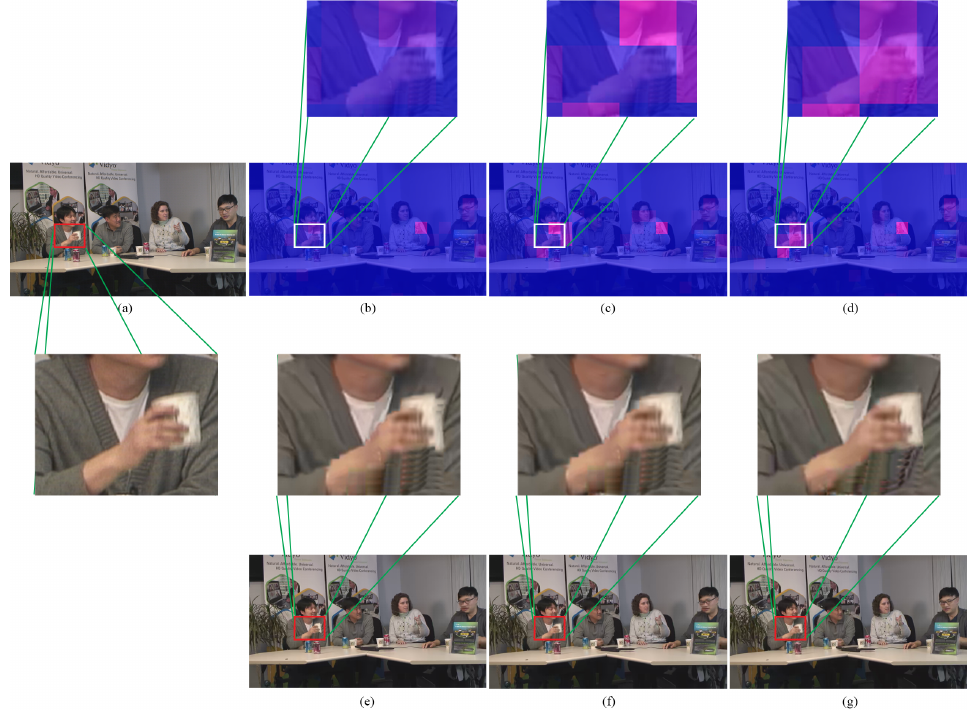
Figure 8. Bit heatmaps and reconstructed frame of inter coding at 384 kbps: ( a ) original frame, ( b , e ) RC-HEVC, ( c , f ) PS-GOP, and ( d , g ) proposed